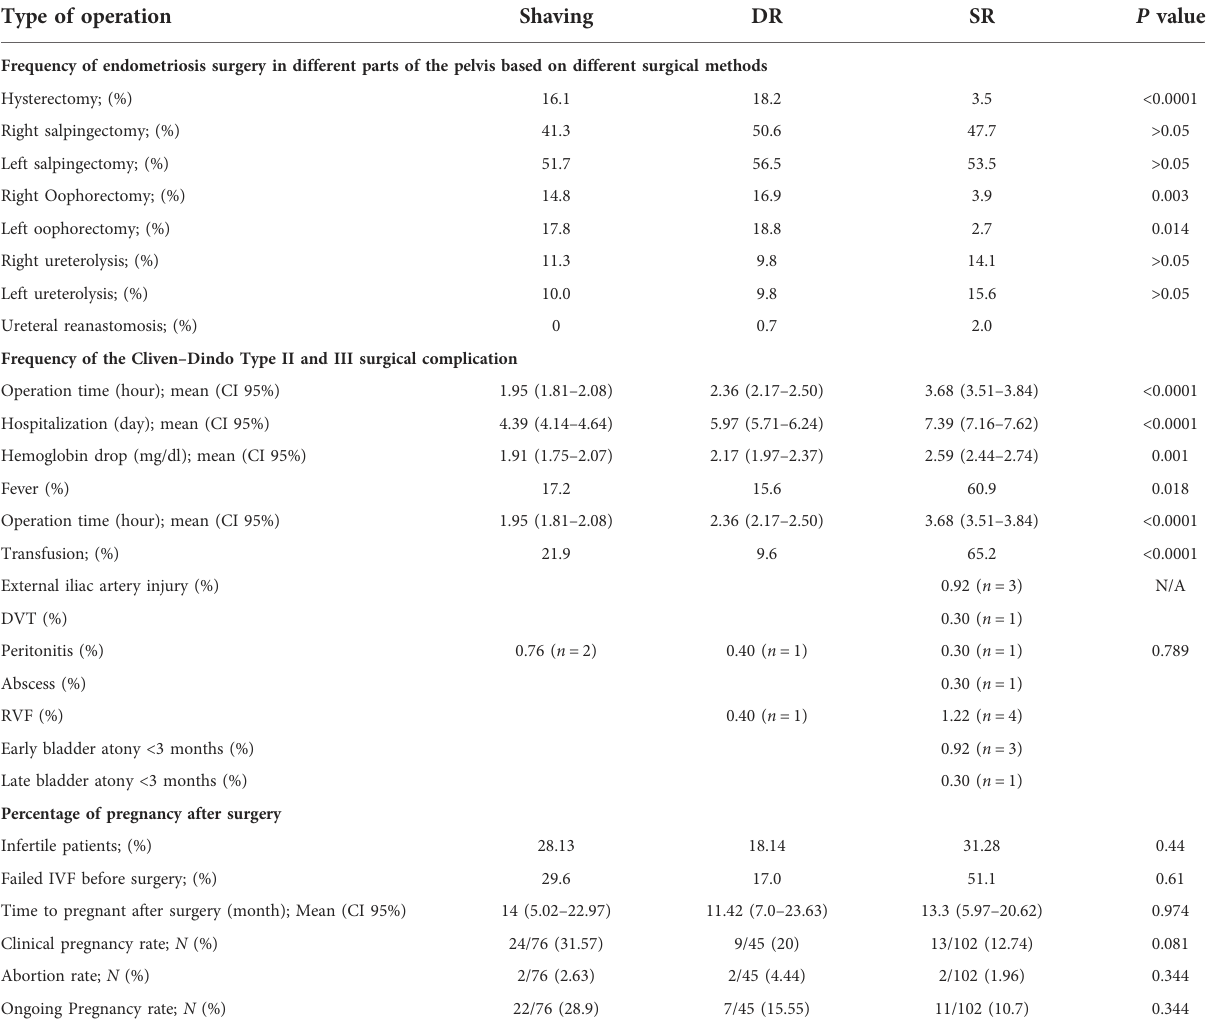
TABLE 3 Frequency of endometriosis surgery in different parts of the pelvis, the Cliven – Dindo Type II and III surgical complication and percentage of pregnancy after surgery based on different types of colorectal endometriosis surgeries. Type of operation Shaving DR Frequency of endometriosis surgery in different parts of the pelvis based on different surgical